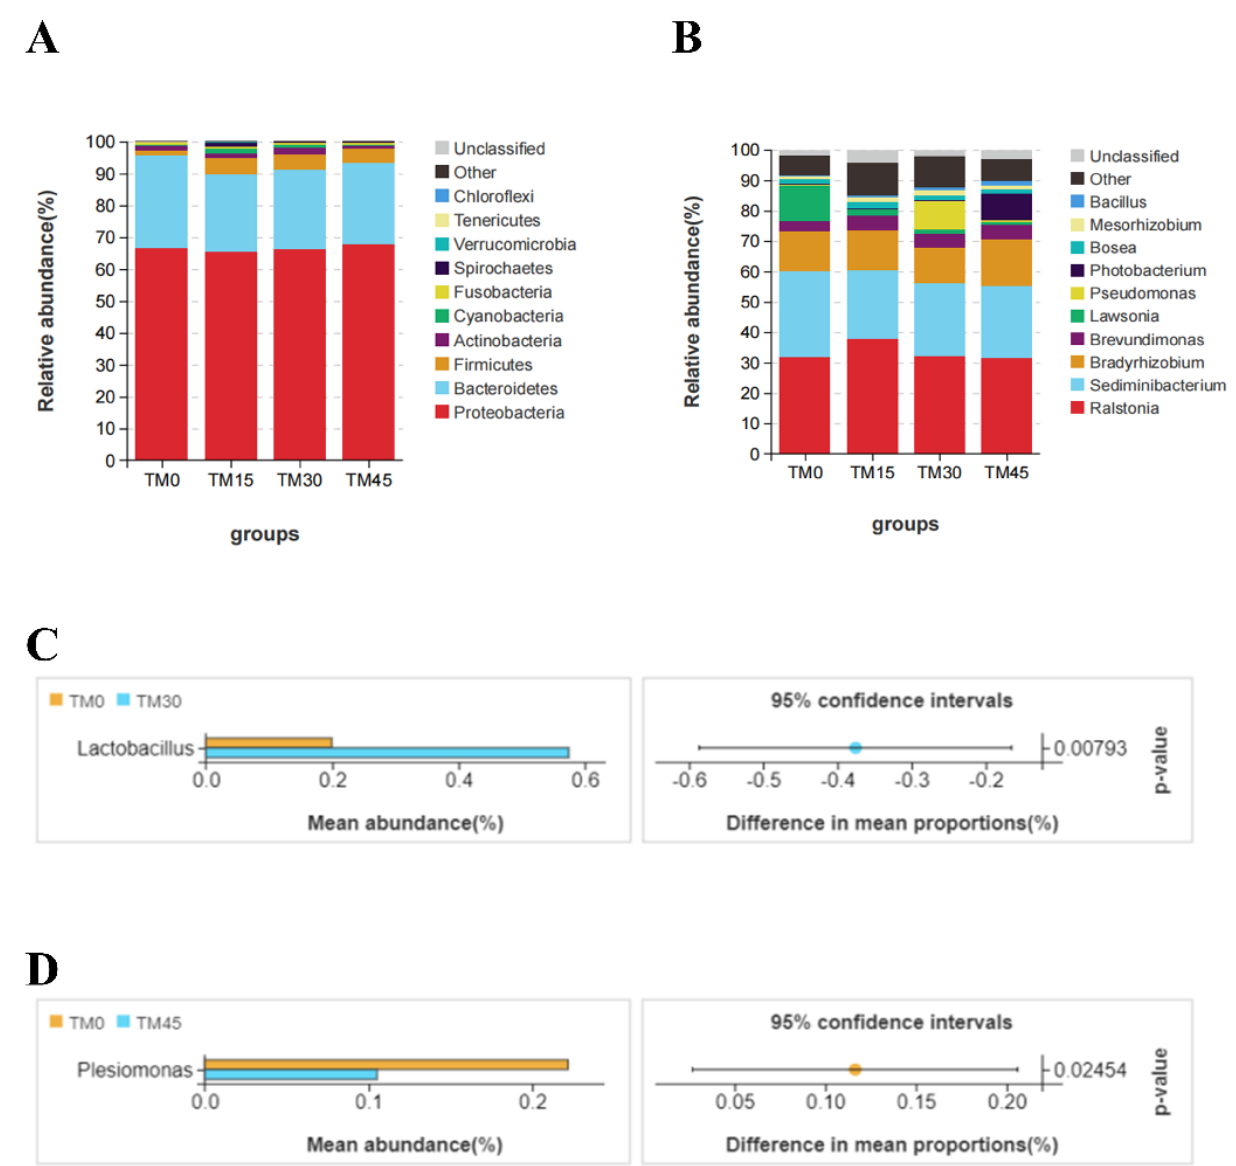
Figure 5. Barplot ( A ) and barplot ( B ) were used to represent the relative abundance of the major intestinal bacterial phyla and genera, respectively. Differences in ( C ) Lactobacillus and ( D ) Plesiomonas were calculated by Welch’s t -test ( p < 0.05).